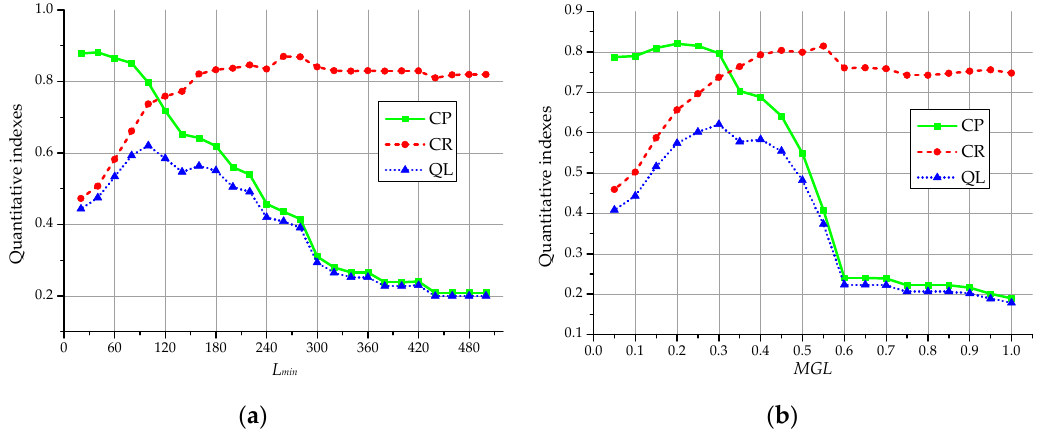
Figure 13. ( a ) The quantitative indexes (CP, CR, QL) versus the pixel length threshold L min while MGL